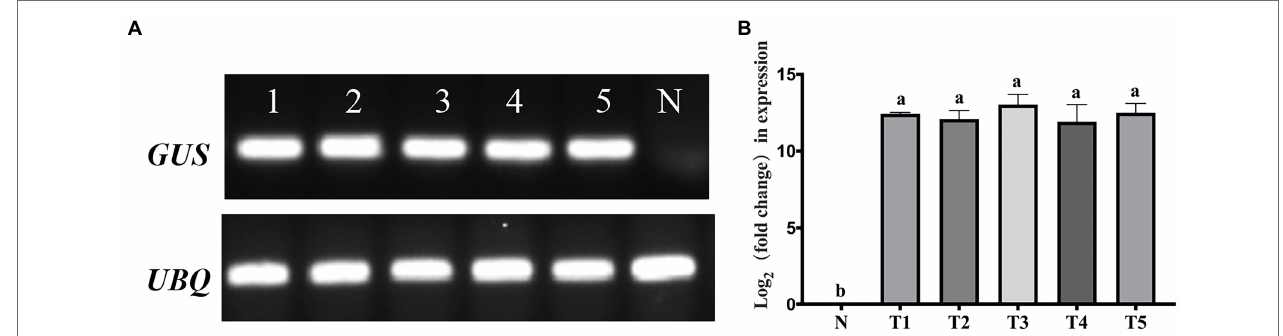
FIGURE 8 | Polymerase chain reaction (PCR) detection of the ß -glucuronidase ( GUS ) gene at the RNA level of transgenic lines. (A) Real-time (RT)-PCR detection of the GUS gene. (B) Quantitative real-time (qRT)-PCR determined the levels of the GUS gene. N, negative control (non-transgenic sample). Lines 1–5 and T1–T5 represent transgenic plants. A one-way analysis of variance (ANOVA) test was used for statistical analysis. Values marked with different letters indicate statistical significance at p < 0.05 by Tukey test.